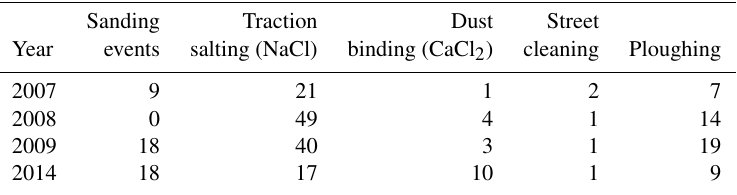
Table 2. The number of road maintenance measures in Hämeentie for four years. The number of ploughing events was computed using the NORTRIP model.